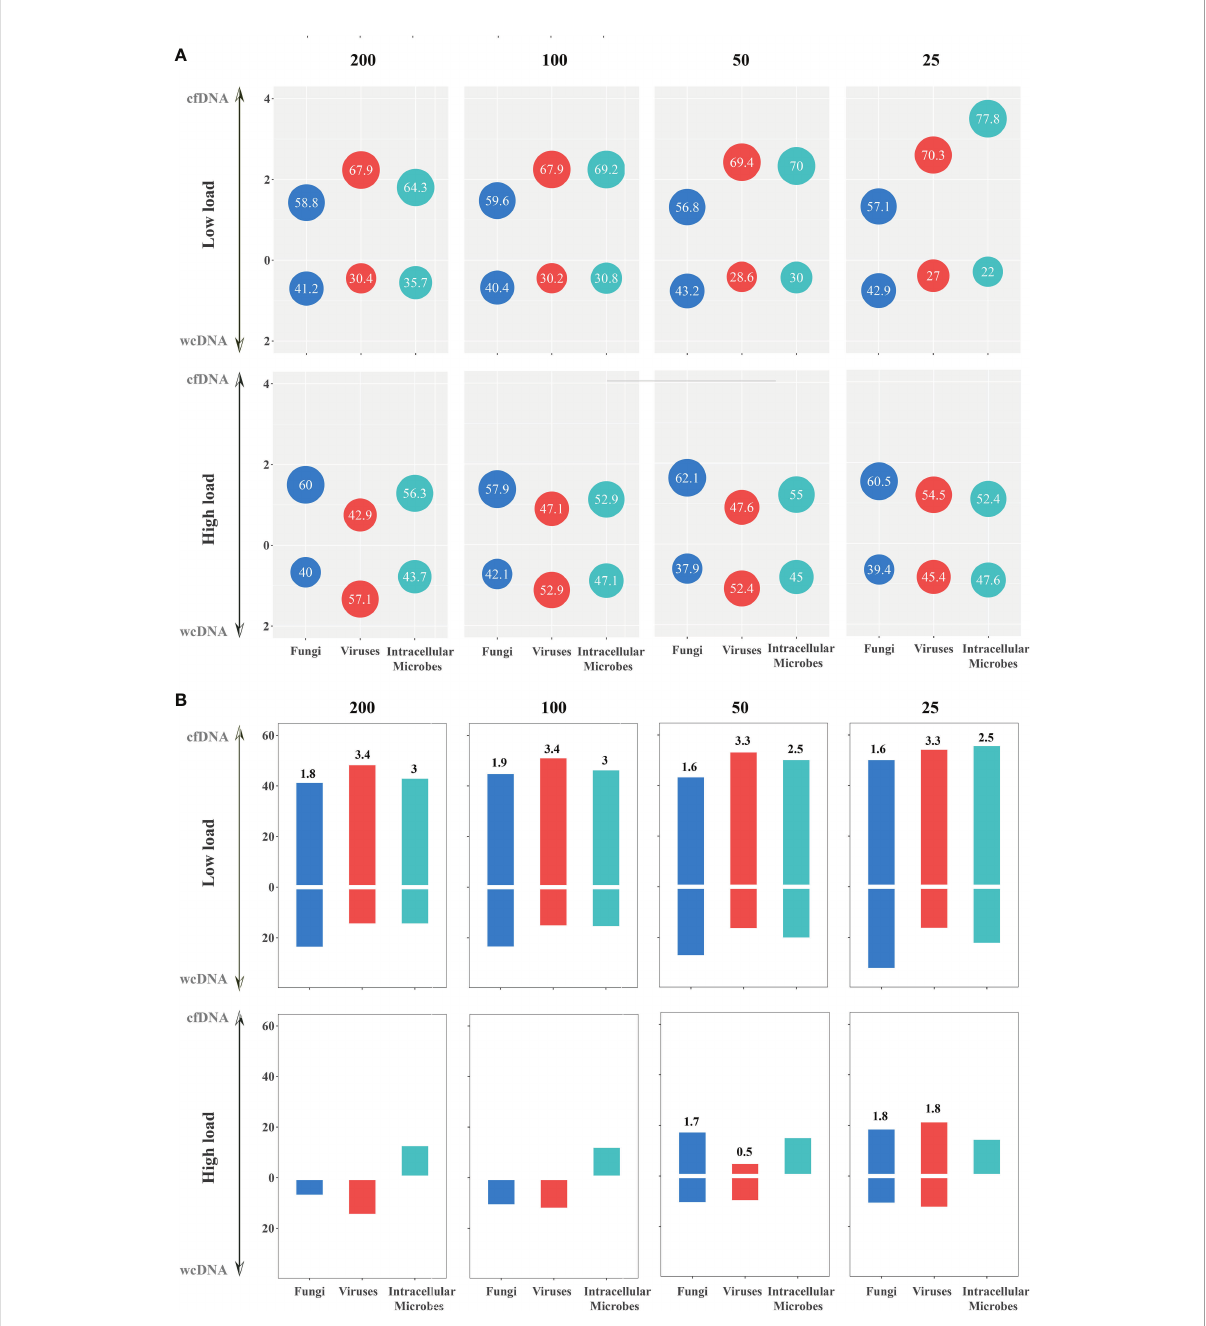
FIGURE 4 The detection of mNGS using cfDNA and wcDNA at different thresholds (RPM of 200, 100, 50, and 25). (A) Detection summary of fungi, viruses, and intracellular microbes by mNGS of both cfDNA and wcDNA at high and low loads. The number in the bubble above the horizontal axis is the ratio of the microbes with more RPM by mNGS of cfDNA than mNGS of wcDNA to the whole microbes at this threshold, while the number in the bubble below the horizontal axis is the ratio of the microbes with more RPM by mNGS of wcDNA than mNGS of cfDNA. Besides, vertical axis coordinate is the ratio of the numbers in the bubble. (B) Detection summary of fungi, viruses, and intracellular microbes only detected by mNGS of cfDNA or wcDNA at high and low loads. The column is the ratio of the microbes only detected by mNGS of cfDNA or wcDNA to the whole microbes at this threshold. The number above the column is the ratio of the microbes only detected by mNGS of cfDNA divided by that only detected by mNGS of